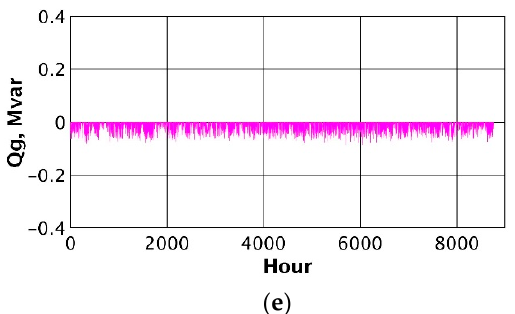
Figure 14. Changes in reactive power generation and absorption of individual RES in the voltage control process according to the simplified method—OLTC + Q ( U ) ( a ) G1, ( b ) G2, ( c ) G3, ( d ) G4, ( e ) G5.